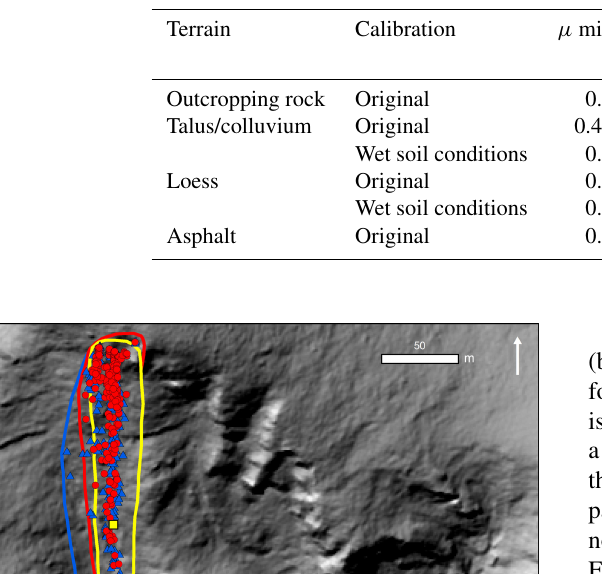
Table 4. RAMMS terrain parameters (as described in Table 3) for typical Port Hills terrain types, calibrated to the original data set and adjusted to wet soil conditions.